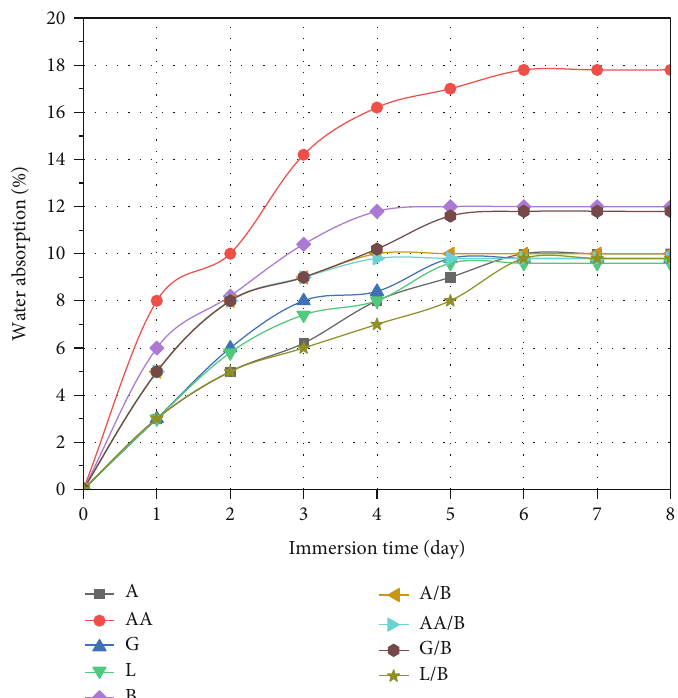
Figure 4: WA for DPF and hybrid composites.